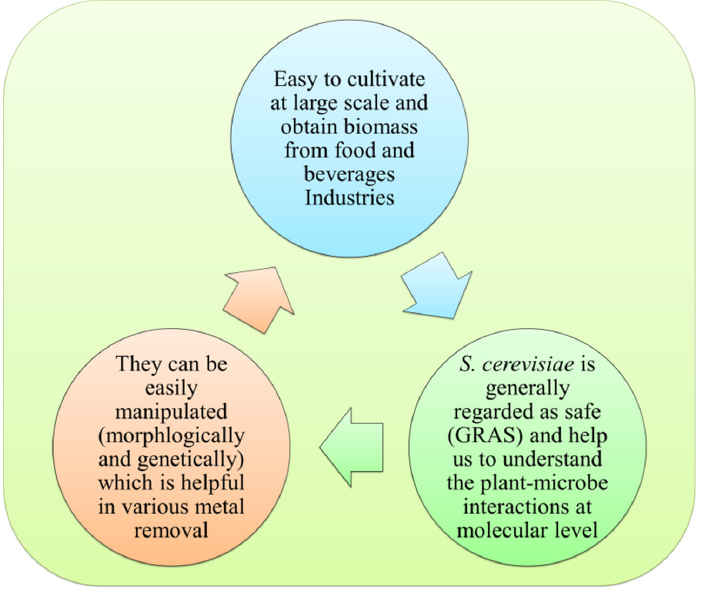
Figure 4. Saccharomyces cerevisiae -mediated plant growth promotion and arsenic remediation.